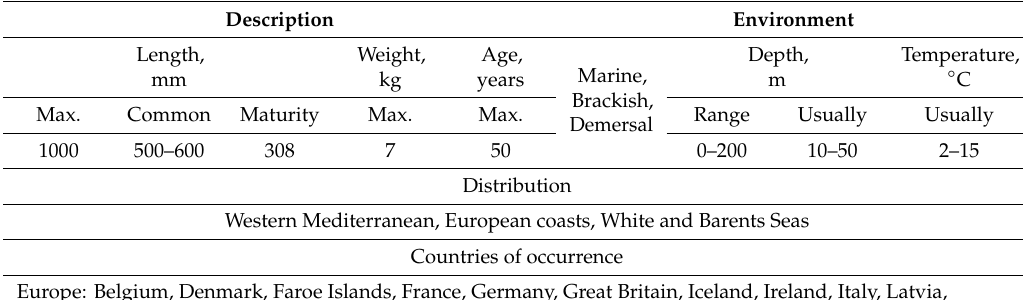
Table A2. General morphological characteristics and basic information (environment, distribution, countries of occurrence) of the European Plaice ( Pleuronectes platessa